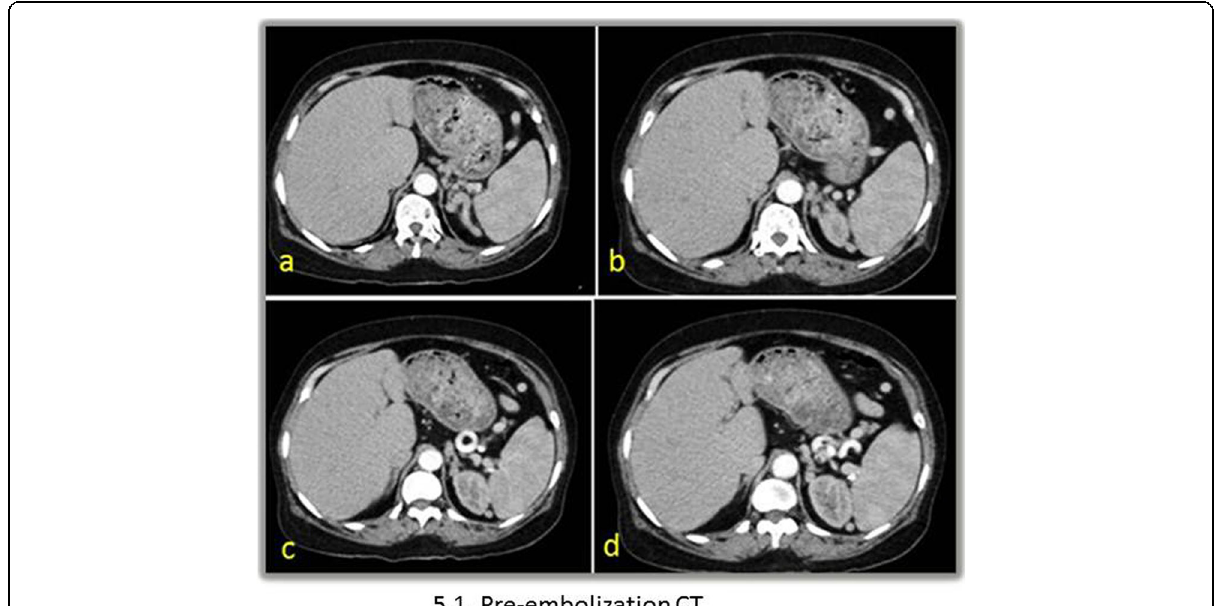
Fig. 10 Female patient, 48 years old, with chronic HCV, referred for correction of thrombocytopenia. Pre-embolization post-contrast CT examination. a – d Axial images at the arterial phase showing diffuse hepatic disease with mild splenomegaly. e , f Multiplanar reformatted coronal and sagittal images at the portovenous phase confirming presence of mild splenomegaly